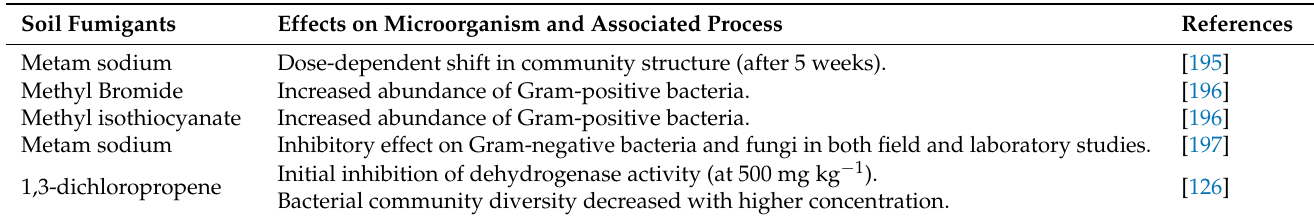
Table 4. Different soil fumigants with their reported effects on soil microorganisms and biochemi- cal